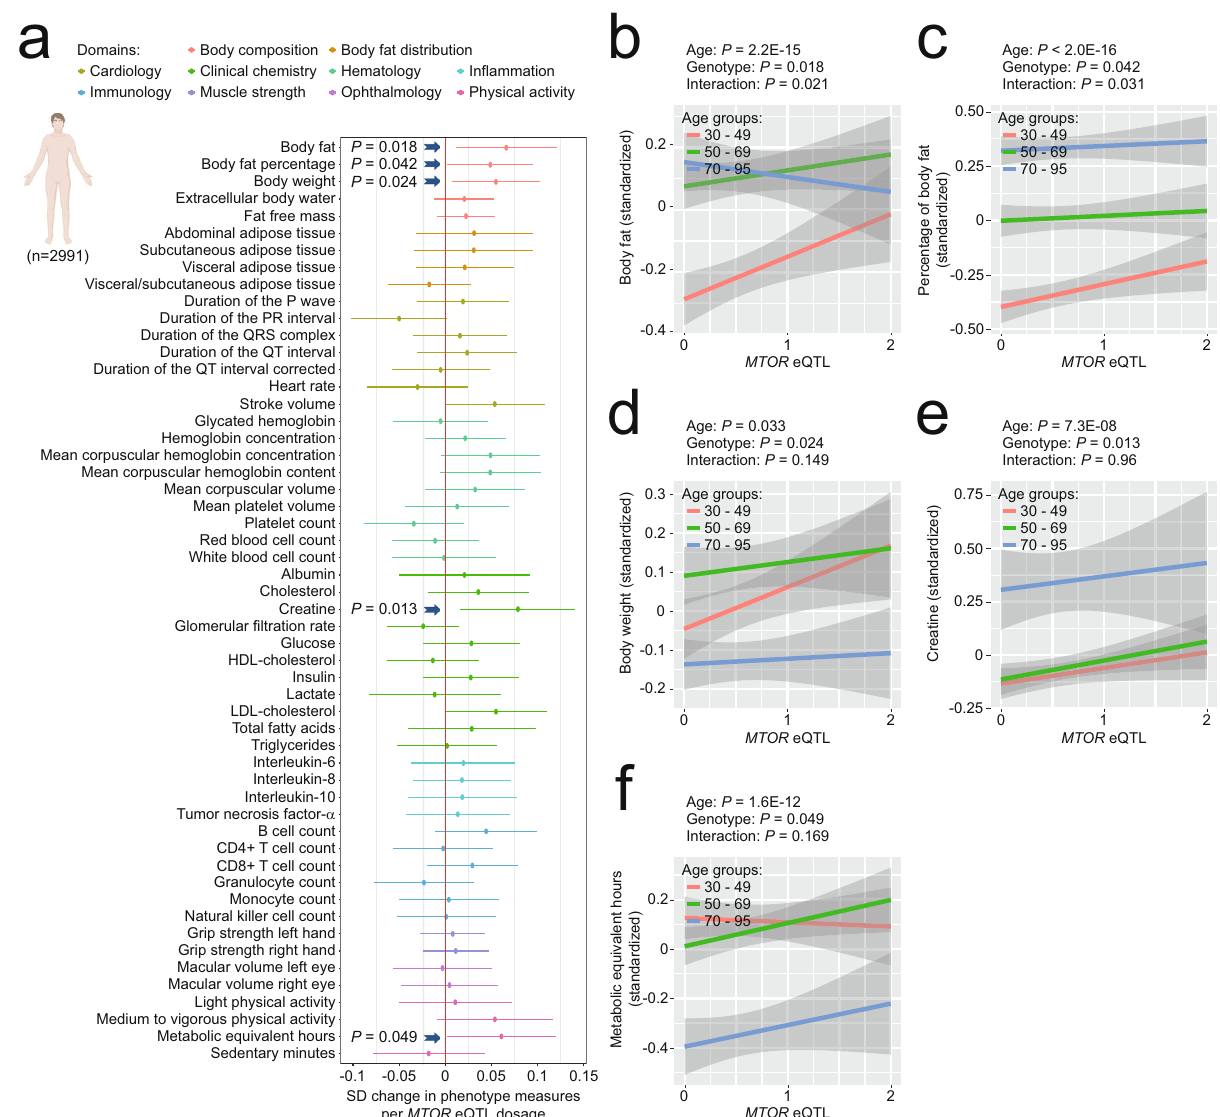
Fig. 7 | MTOR eQTL effects on aging-associated phenotypes in humans. a – f Phenotyping results in a human cohort that included participants of both genders with an age range from 30 – 95 years. a Change in phenotype associated with MTOR eQTL dosage in a large deep-phenotyped human cohort, with the horizontal whiskers indicating the 95% con fi dence intervals of the mean effect estimate;* denotes p <0.05for the linearassociation between MTOR eQTLdosage and phenotype The association between eQTL dosage and each phenotypic mea- surewasassessedusingmultiplelinearregressionmodelsadjustedforage,sexand population strati fi cation using the fi rst ten genetic principal components. Our